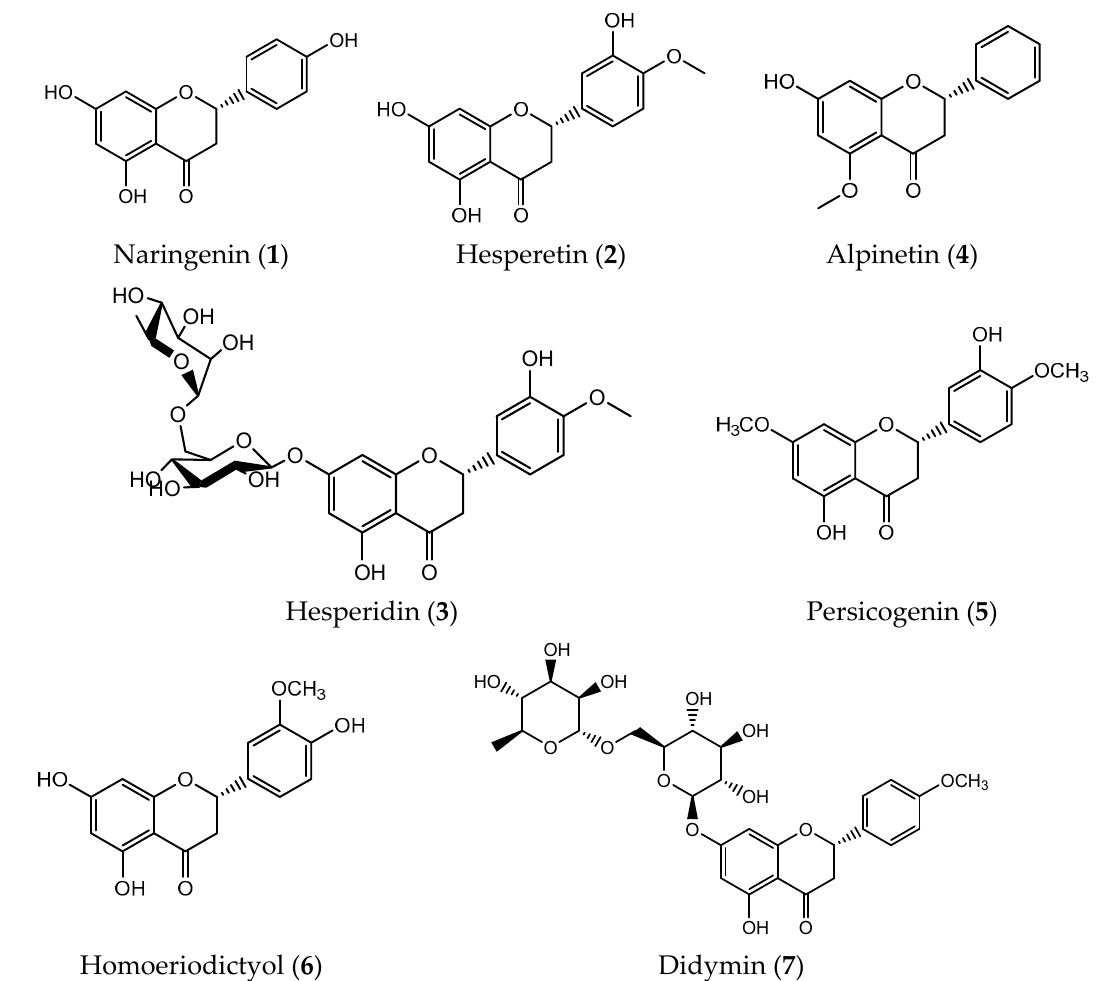
Figure 1. Natural chiral flavanones with antitumor activity.